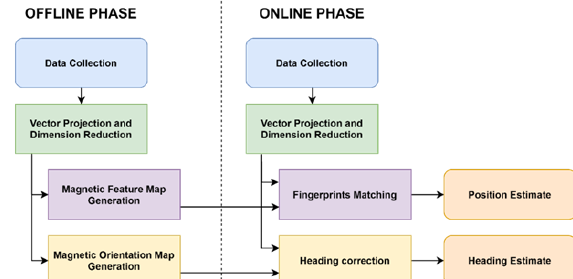
Figure 1. The overall flow-chart of magnetic fingerprint-based positioning